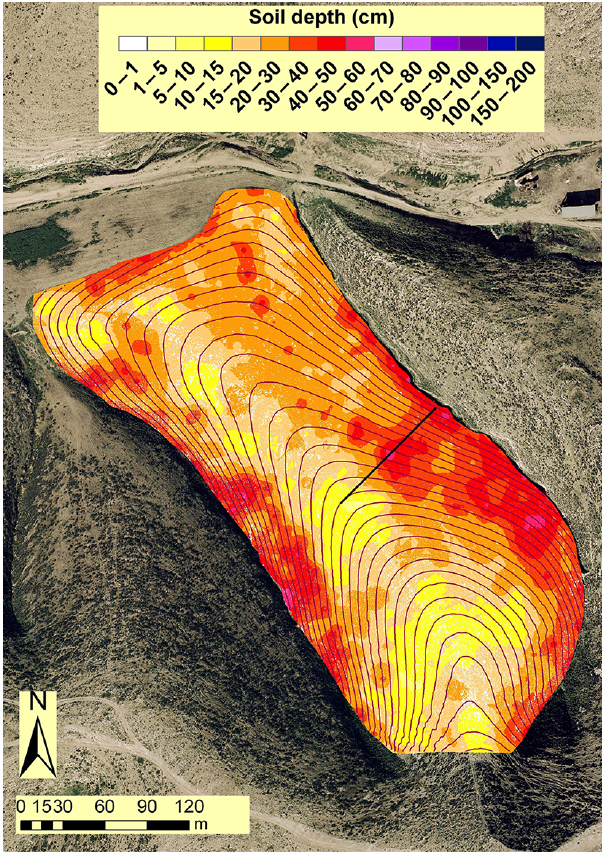
Figure 2. Soil depth at the Lehavim LTER site, measured in 550 lo- cations and interpolated using Kriging. Pixels classified as rock from a 10cm 2 orthophoto were assigned zero depth. The contour lines are at 2m intervals and the thick black line is the location of the transect analyzed in Sect.